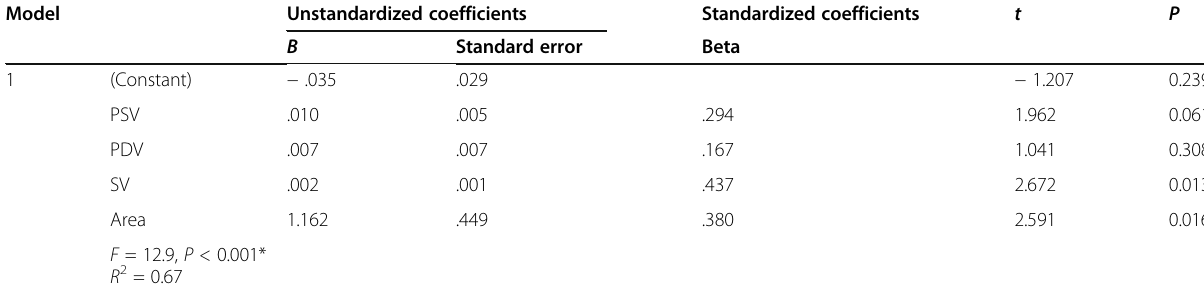
Table 4 Linear regression for prediction of MF among studied cases